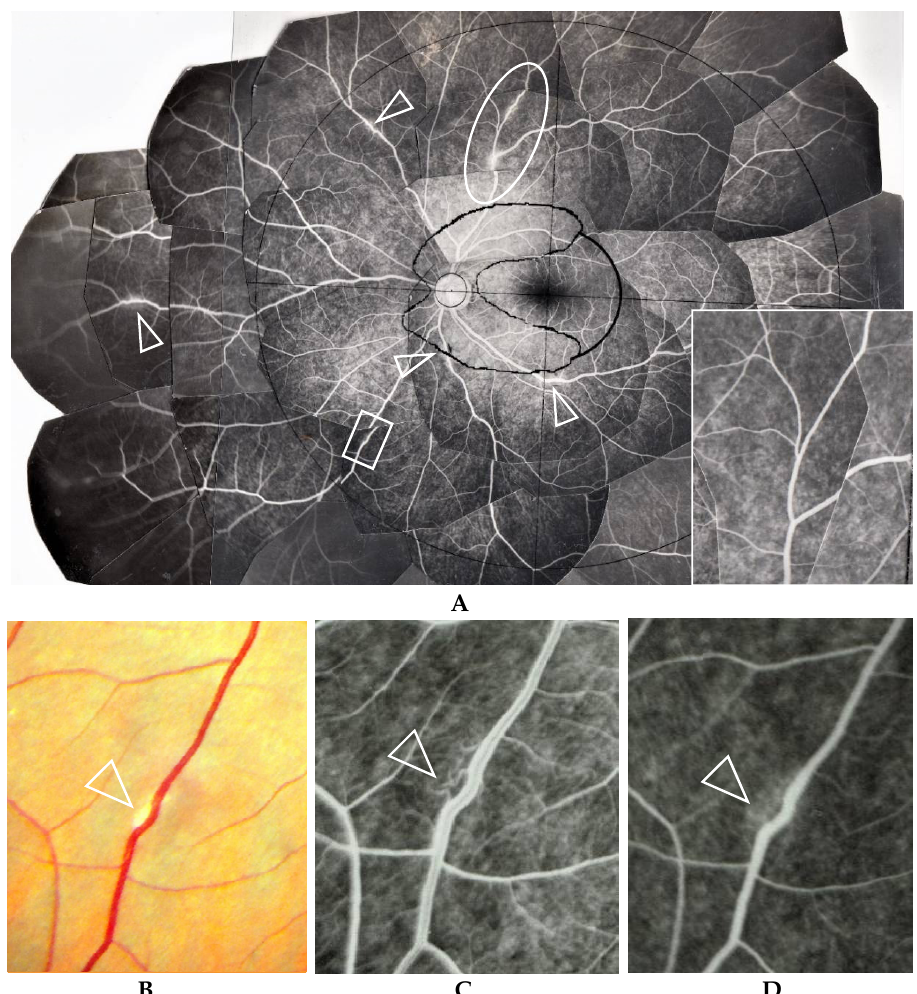
Figure 4. ( A – D ) Images of the right eye of Case 40, a 23-year-old male in Group II with a max IOP of 14 mmHg. Photographs of FFA mounted on a transparent sheet with different zones ( A ) and fundus ( B ). Photograph C and D (early stage ( C ) and late stage ( D ) of fluorescein injection) are high magnification images of the boxed area in ( A ). The FFA photograph in A , inset is the oval-shape encircled area shown in A taken 2.8 years after the FFA of A. Nodules in the retina completely disappeared in 2.8 years ( A , inset) with no systemic steroid medication. Arrowheads in A : perivascular nodules. Postcapillary venules became dilated (arrowhead in C ) and showed leakage (arrowhead in D ) in the nodule adjacent to the vein (arrowhead in B ).